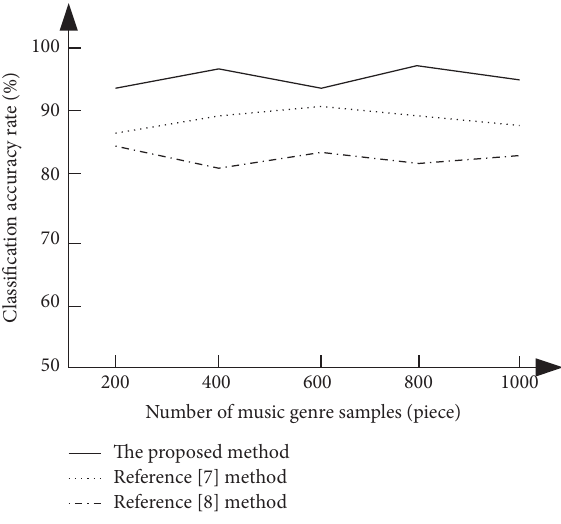
Figure 7: Comparison results of automatic classification accuracy of music genres by different methods.